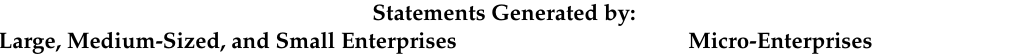
Table A2. Comparison of financial statements of enterprises of di ff erent sizes—statement of profit or loss.